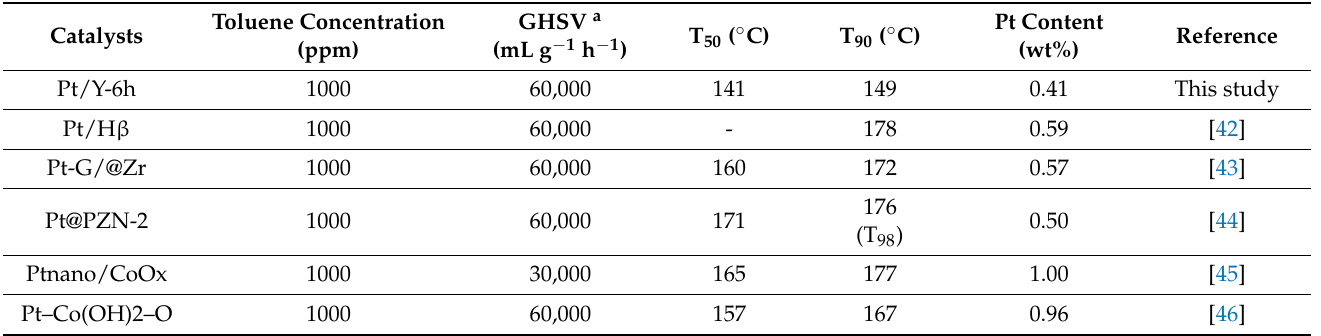
Table 5. Performance comparison of the Pt-supported catalysts for toluene